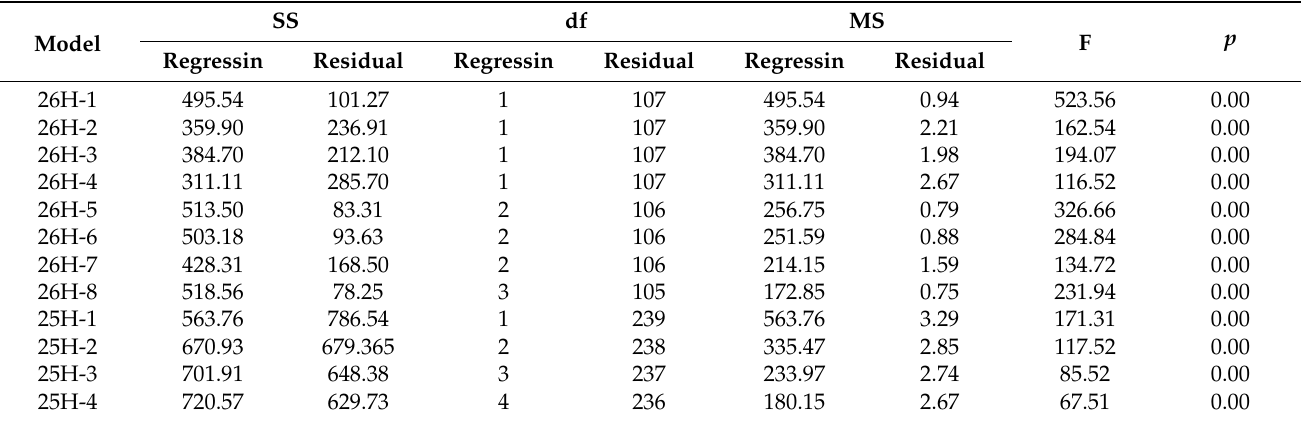
Table 3. ANOVA test for all models: sum of squares (SS), degree of freedom (df), mean square (MS), F-statistic (F) and p -value ( p ) for setpoint temperature of 26 and 25 ◦ C for hourly data (H).